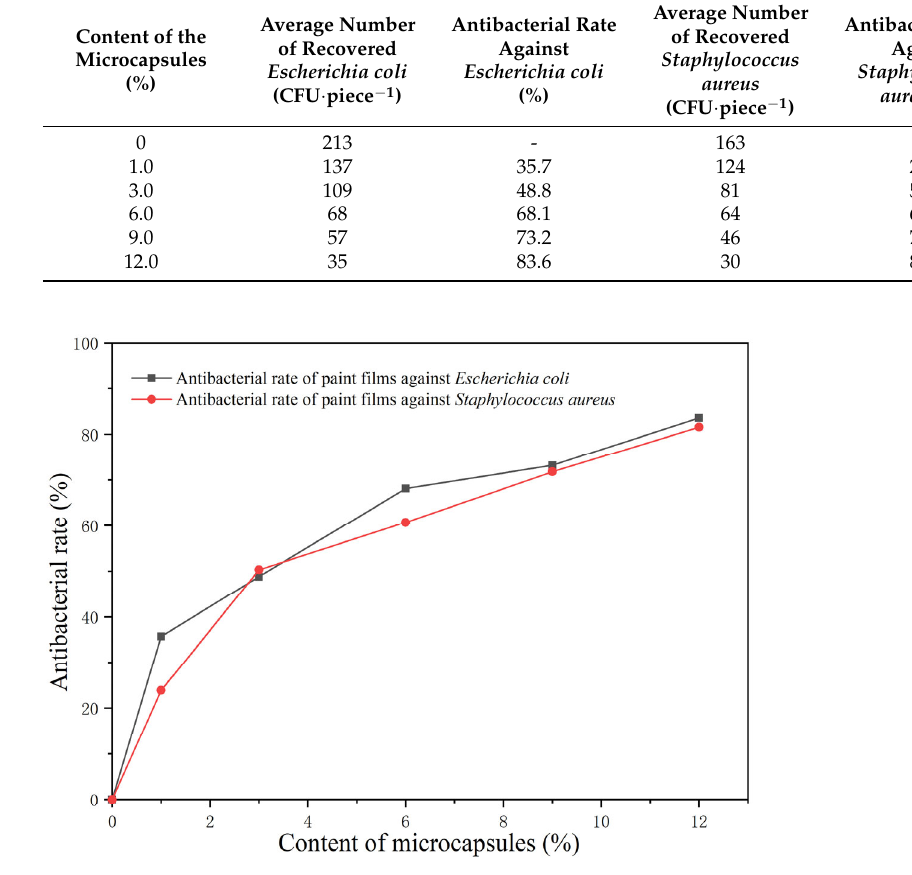
Figure 11. Antibacterial rates of the paint films.